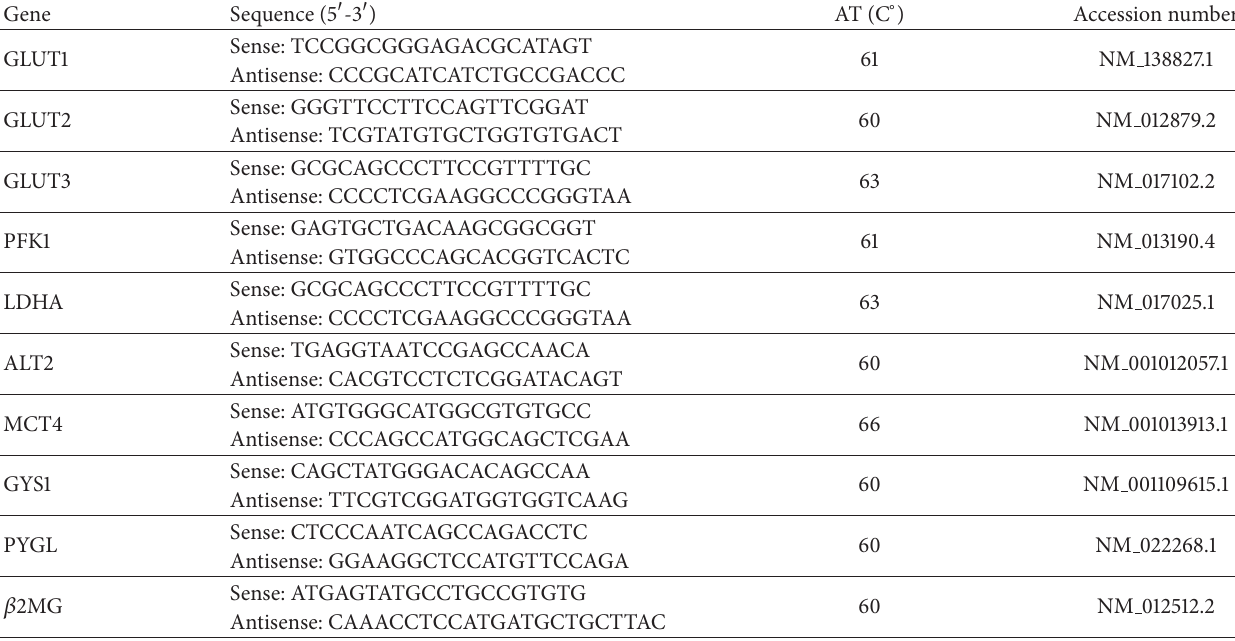
Table 1: Oligonucleotides and cycling conditions for PCR amplification of GLUT1, GLUT2, GLUT3, PFK1, LDHA, MCT4, ALT2, GYS1, PYGL, and 𝛽